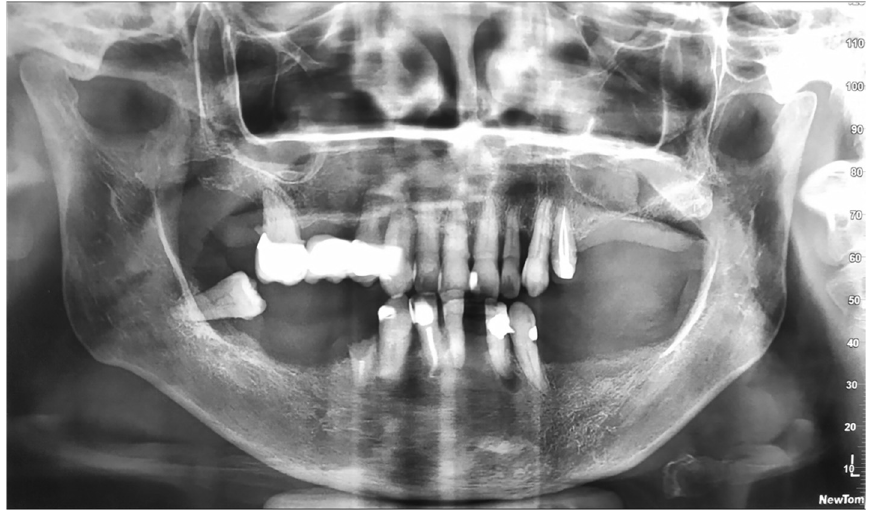
Figure 2. Panoramic radiograph (January 2020).